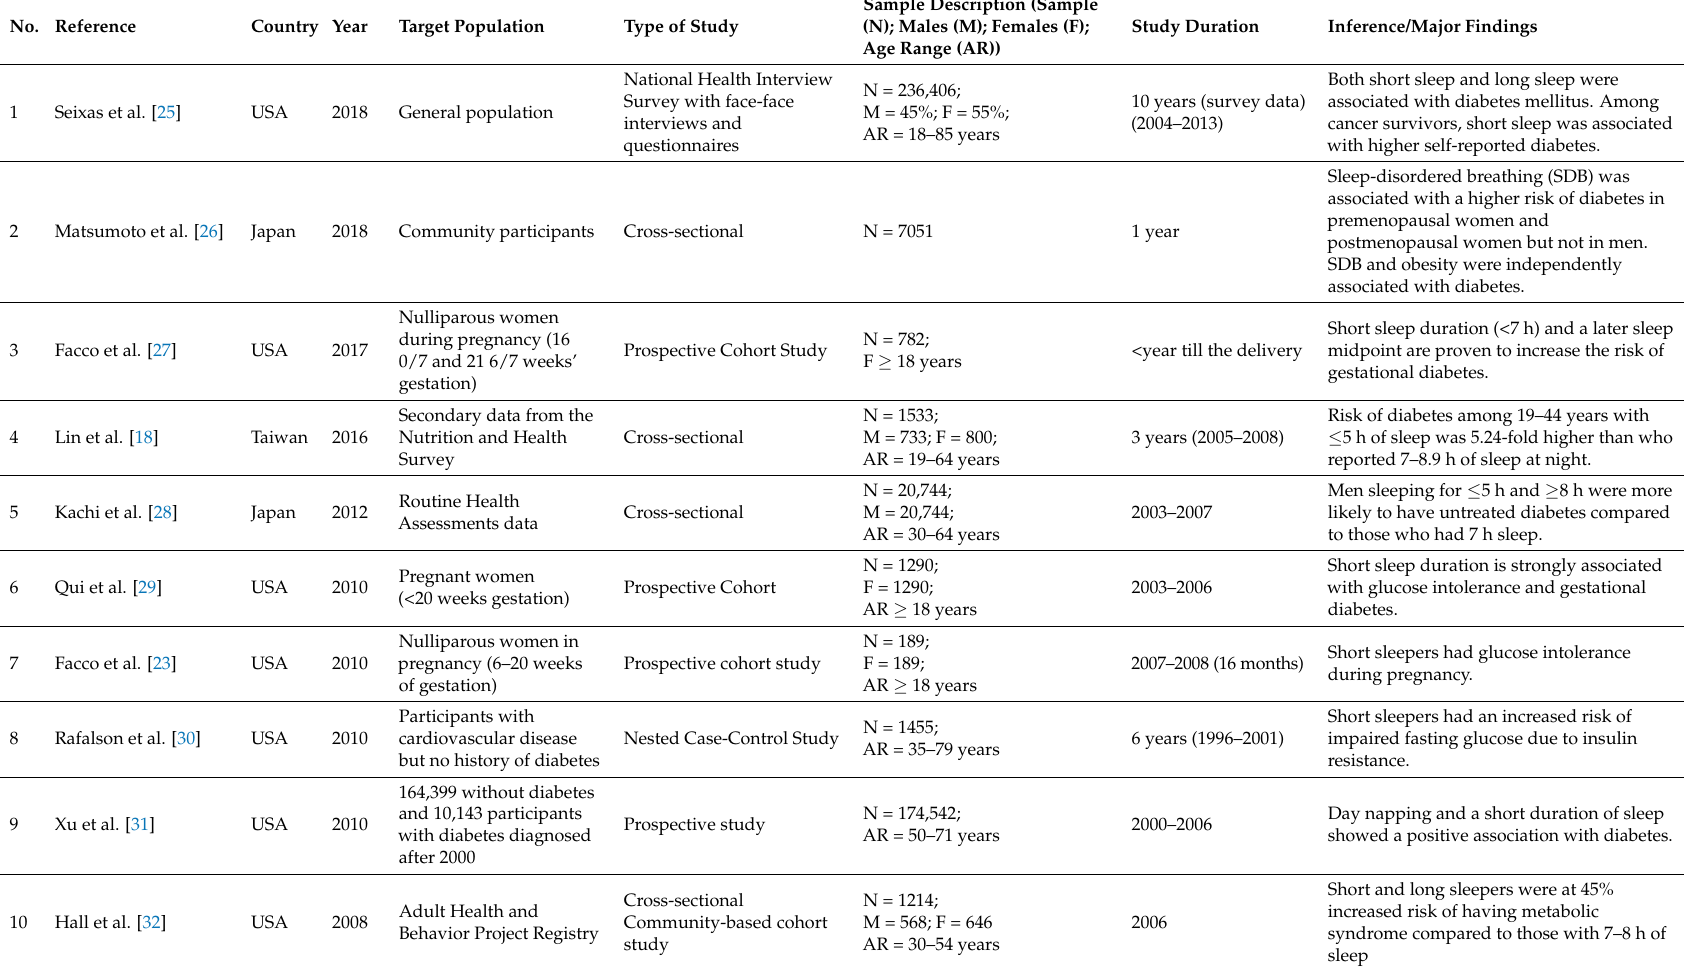
Table 1. Evidence on sleep deprivation and diabetes mellitus from various